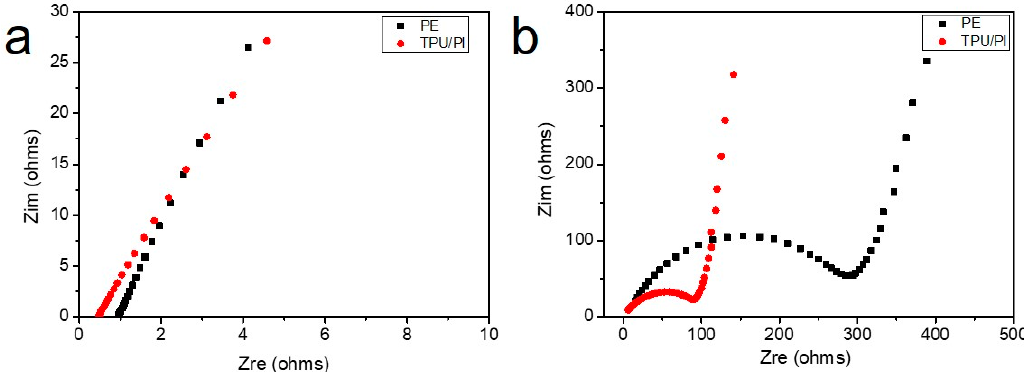
Figure 6. ( a ) EIS of PE and TPU/PI membranes, ( b ) EIS of batteries assembled with PE and TPU/PI TPU/PI membranes.